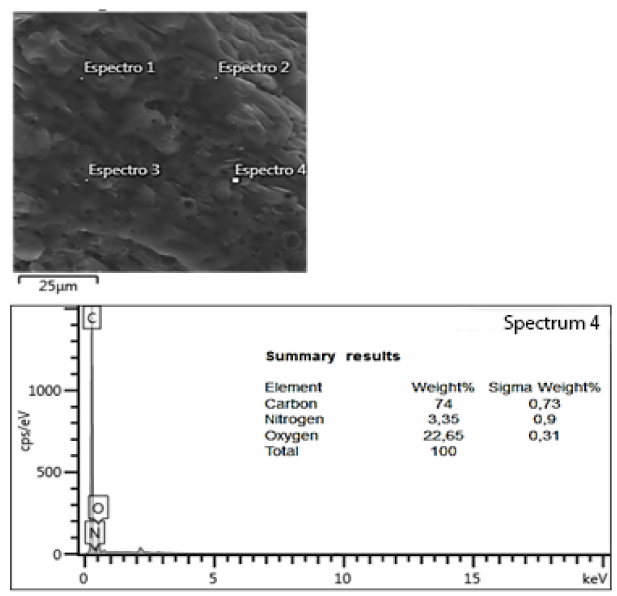
Figure 3. EDS image and corresponding spectrum of area 4 with weight percentages.